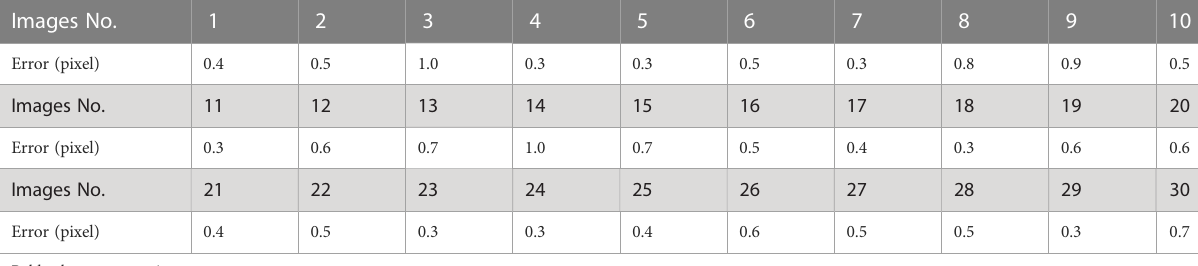
Bold values represent image sequences.